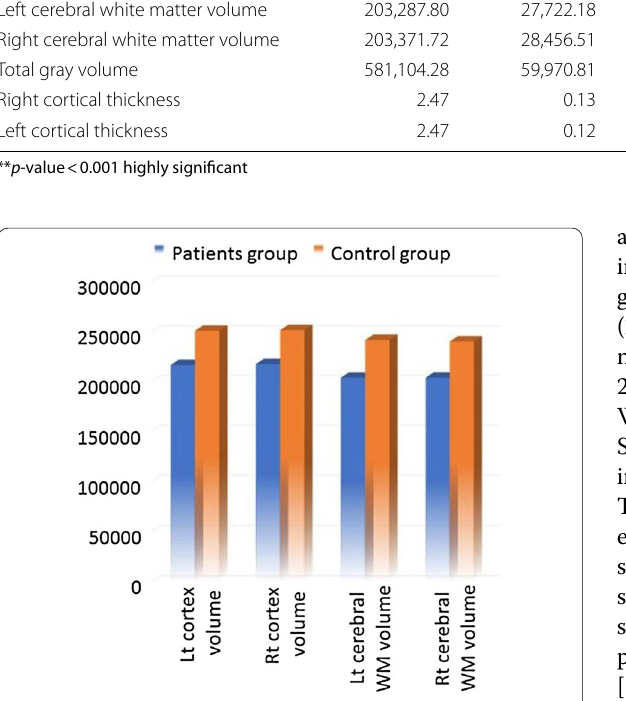
Fig. 1 Comparison between patients’ group and control group with regard to bilateral cortical volume and cerebral white matter